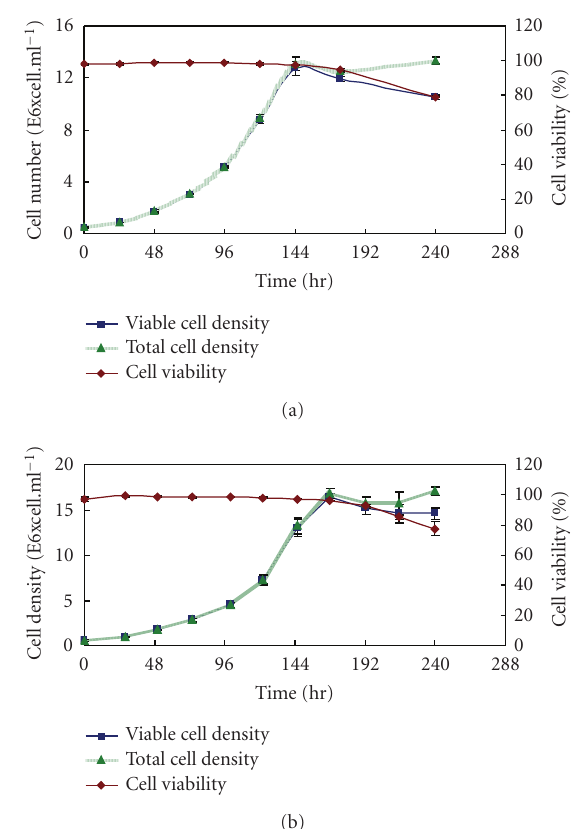
Figure 3: Growth curves of the stably transfected Sf9 producing hIL-7 and nontransfected Sf9 insect cells. (a) Viable cell density, total cell density, and viability of stably transfected Sf9 with pIE1/153A (V4)/hIL-7 plasmid. Cells were seeded at a density of 5 × 10 5 cells · mL − 1 and maintained at 1 × 10 7 cells · mL − 1 . (b) Viable cell density, total cell density, and viability of nontransfected Sf9 insect cells. Cells were seeded at a density of 5 × 10 5 cells · mL − 1 ( n =